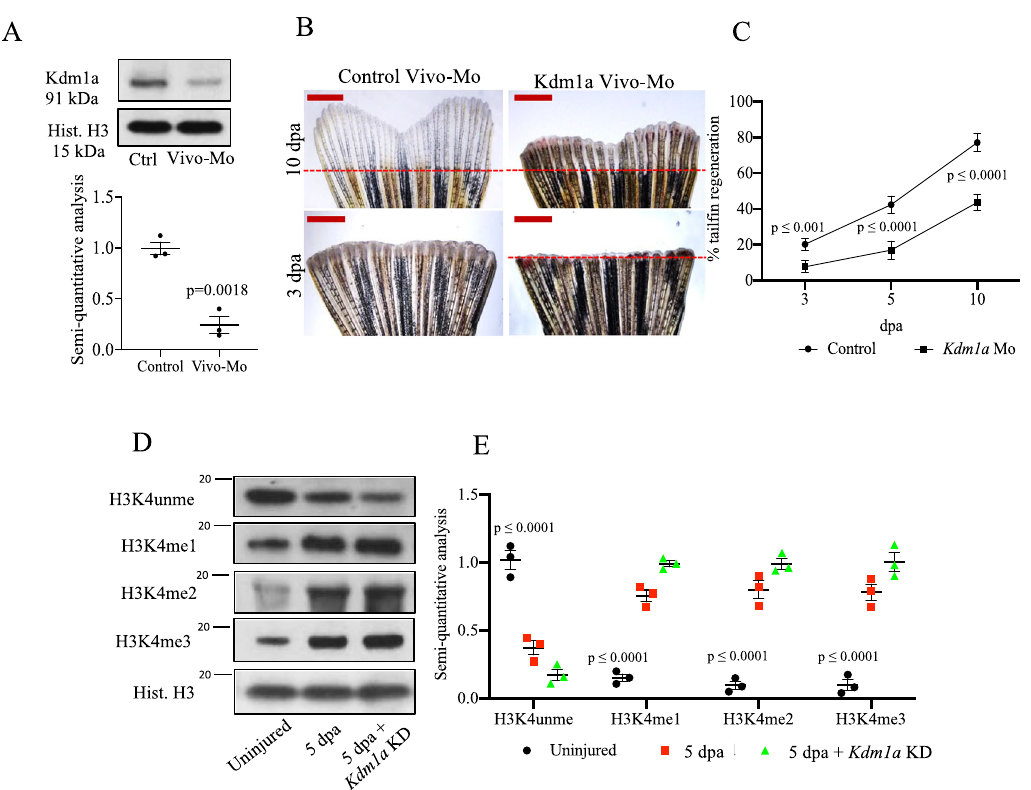
Fig. 4 Effects of kdm1a knockdown in adult zebra fi sh. A Western blotting (WB) analysis of Kdm1a control and morpholino KD. Dot plot shows semiquantitative analysis of bands. Two-tailed t -test. B Effects of Kdm1a KD on tail fi n regeneration. Dashed red line represents the edge of the resection. Scale bar indicates 2 mm. C Line graph showing changes in tail fi n regeneration rate following kdm1a KD. Two-way ANOVA followed by Bonferroni ’ s multiple comparisons test. D , E WB for H3K4unme (unmethylated), H3K4me1, H3K4me2, and H3K4me3 in control uninjured, injured and injured + kdm1a KD at 5 dpa. Dot plot shows semi-quantitative analysis of bands. Histone H3 was used as loading control. Dpa days post-amputation. Two-way ANOVA followed by Bonferroni ’ s multiple comparisons test, p values indicate comparisons of uninjured vs. other groups. N = 3 biological replicates. Data are presented as mean values + / −